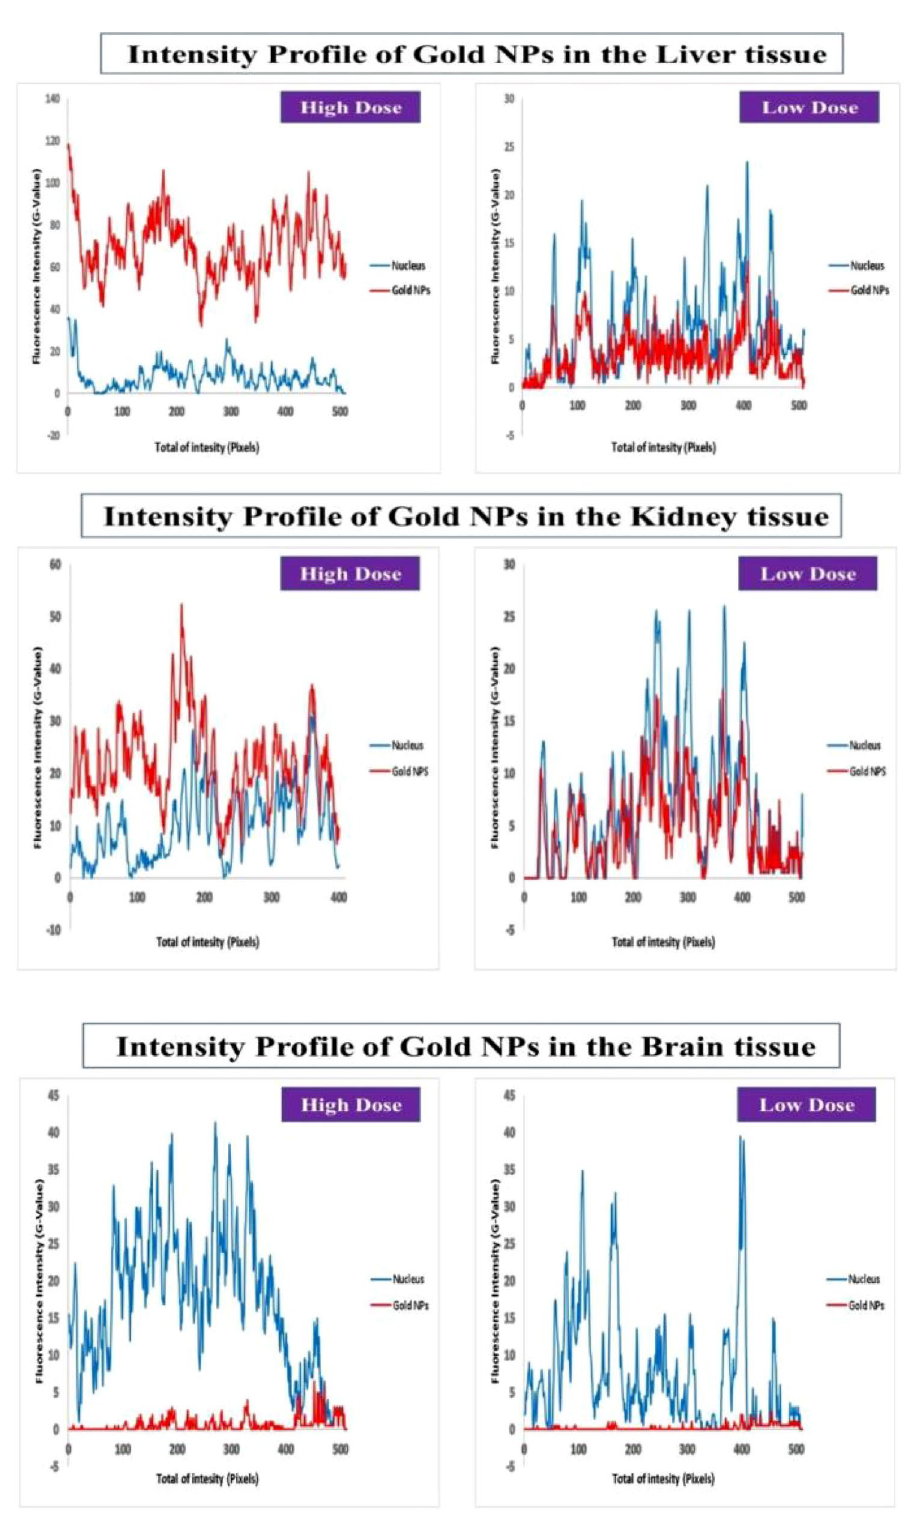
Figure 9. Graph representing the fluorescence intensity profiles of Au-NPs in rat liver, kidney and brain tissues as a function of distance. In liver and kidney tissue, control group showed no red fluorescence because of the absence of Au-NPs, thus acting as a zero- fluorescence base line to exclude the autofluorescence background. The biodistribution of Au-NPs at high dose was significantly higher than that of rat group treated with low dose Au-NPs as evaluated by MFI and mean area % ( p = 0.0013, p < 0.0001 respectively). In brain tissue, control group showed no red fluorescence because of the absence of Au-NPs, thus acting as a zero-fluorescence base line to exclude the autofluorescence background. The biodistribution of Au-NPs at high dose was more prominent than that of rat group treated with low dose Gold NPs as evaluated by MFI ( p = 0.0062 ), on the other hand, there was no significant differences between the two treated groups with respect to the mean area % ( p = 0.3444 ). The square represented the high density of Au-NPs in glia